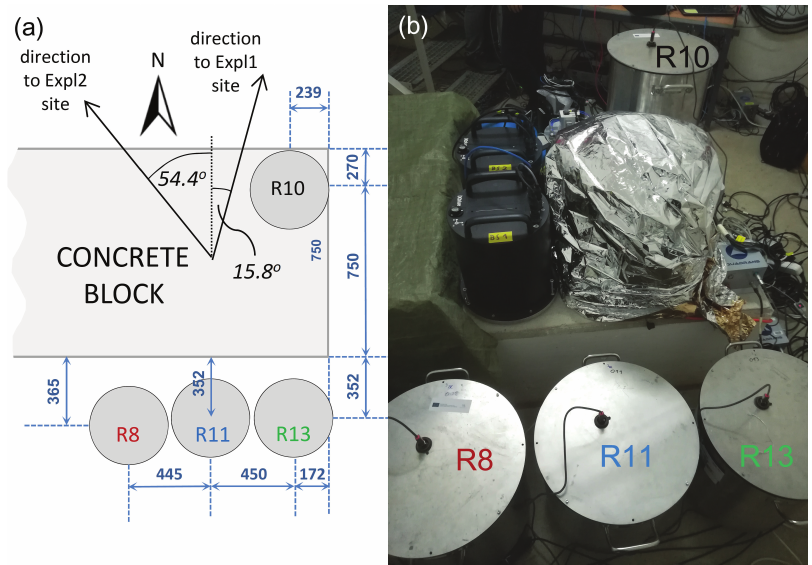
Figure 2. Four Rotaphone-CY instruments (R8, R10, R11, and R13) in the huddle test: scheme showing the positions ( a ) and photograph ( b ). The color coding used to mark individual Rotaphone- CY instruments is kept throughout the manuscript in order to distinguish their records. The numbers refer to distances in mm to the centers of the